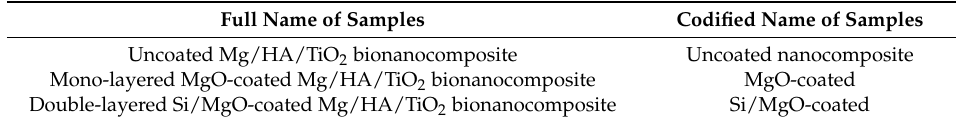
Table 1. Codified names of uncoated and coated